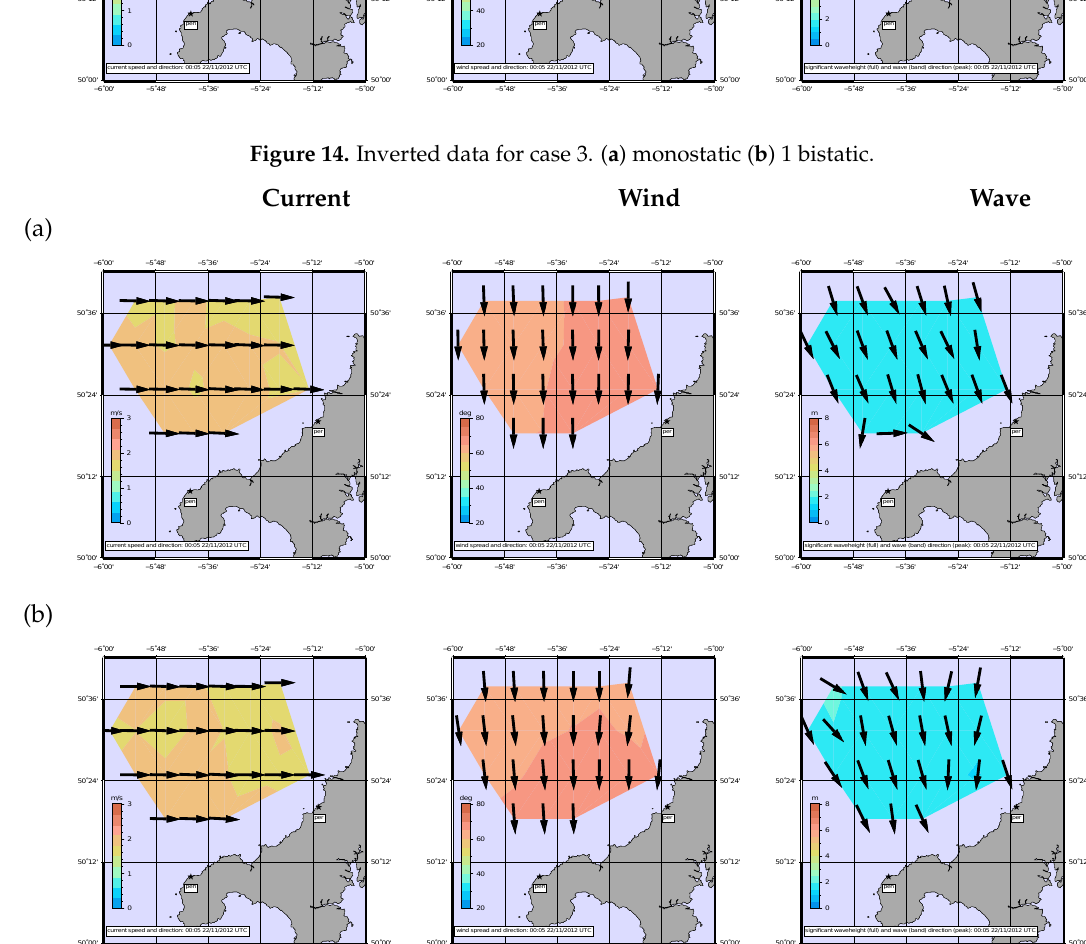
Figure 15. Inverted data for case 4. ( a ) monostatic ( b ) 1